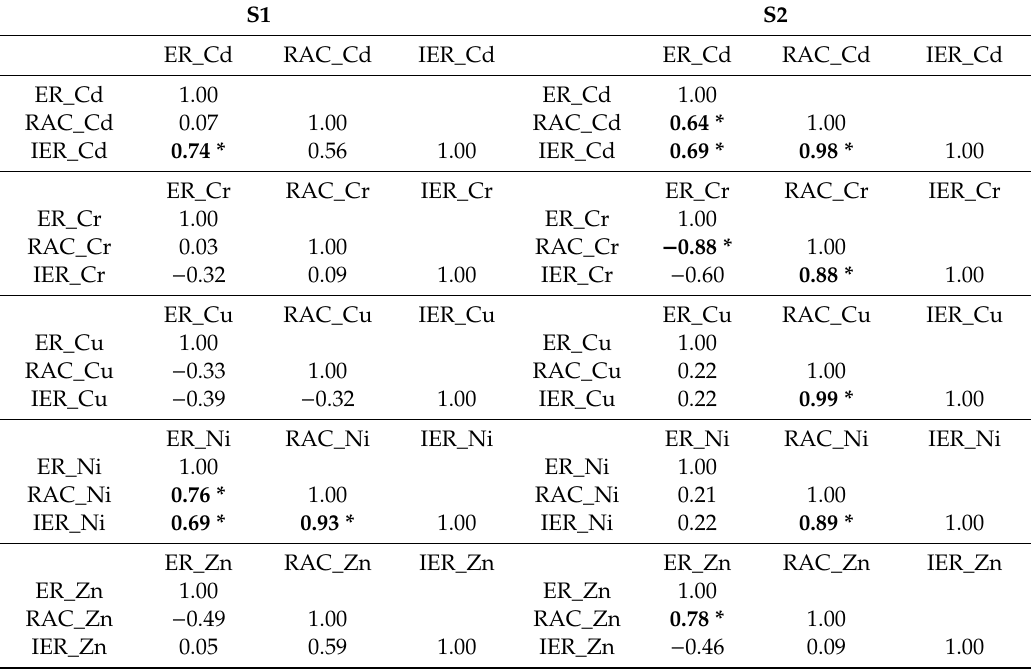
Table 10. Pearson’s correlation matrices of the ecological risk